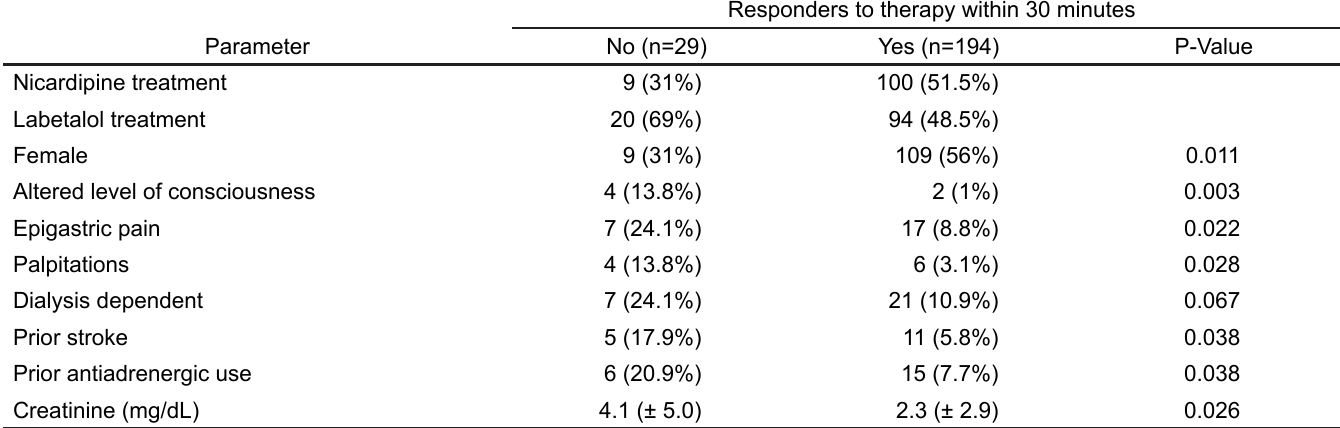
Table 2. Univariate analysis of factors associated with nonresponse to intravenous